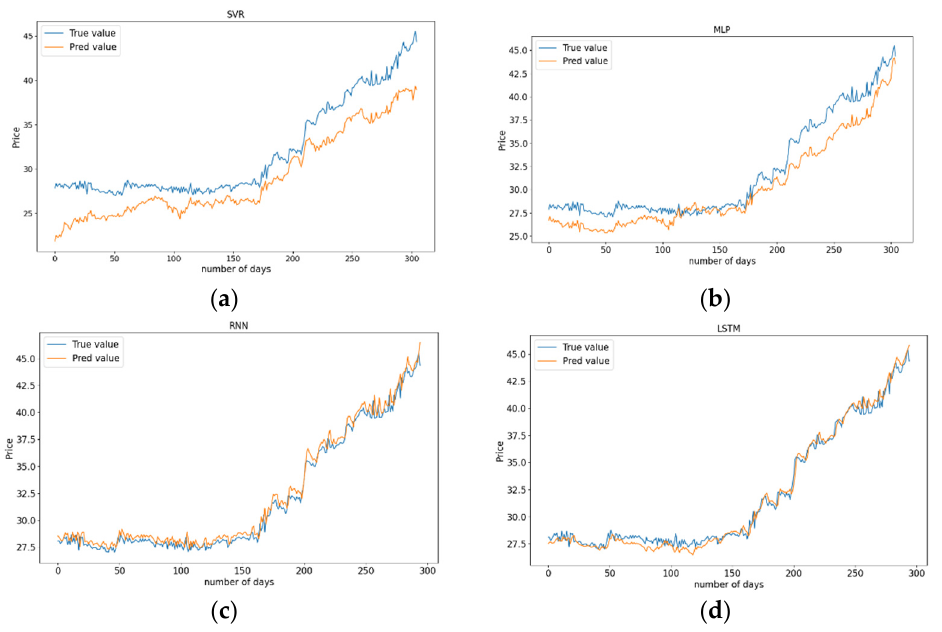
Figure 7. Models predicted and actual GDEA values. ( a ) SVR; ( b ) MLP; ( c ) RNN; ( d ) LSTM.